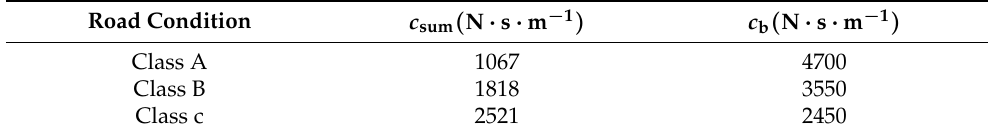
Table 3. Optimized parameter